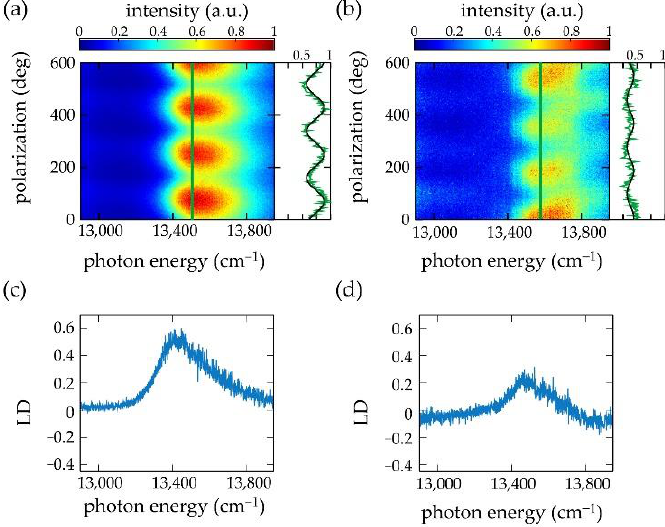
Figure 3. ( a , b ) Polarization-resolved fluorescence-excitation spectrum of two separate individual chlorosomes from the bchR mutant of Cba. tepidum at low temperature (1.5 K). On the right-hand side of the patterns the measured fluorescence intensity (green line) is compared to a cos 2 function (black line) as a function of the polarization of the excitation light at the excitation energy of 13,490 cm −1 ( a ), and 13,576 cm −1 ( b ), respectively, corresponding to the peak energy , ℎ𝜈 𝑝𝑒𝑎𝑘 , of the polarization-averaged spectra indicated in the pattern by the vertical green lines. Note that in ( b ) the reduction of the intensity between about 100° and 400° does not affect the spectral shape of the excitation spectrum. Also, for this chlorosome, the spectral profile is reproduced every 180°. ( c , d ) Reconstructed LD spectra for the two individual chlorosomes.